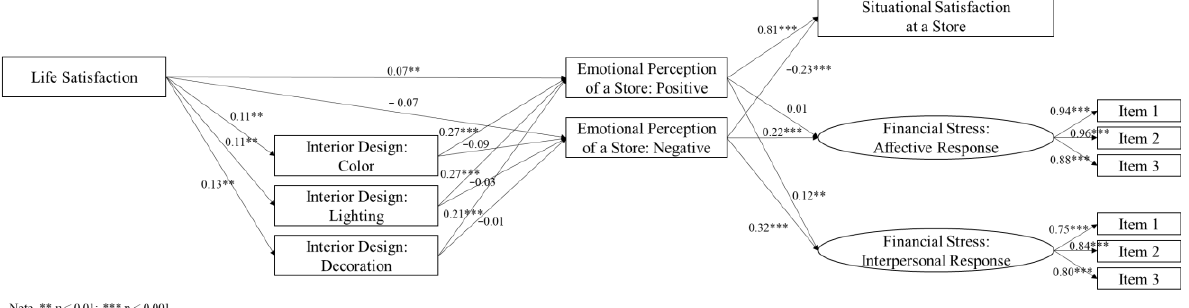
Figure 2. Structural equation modeling results.